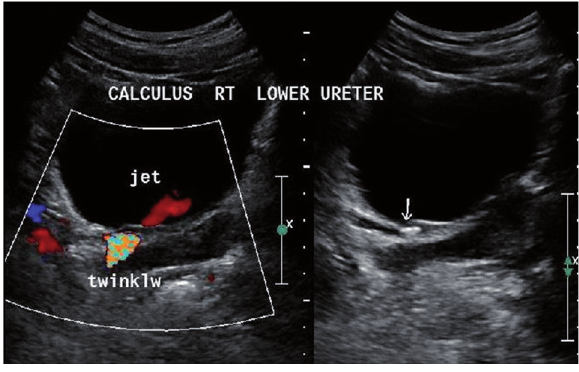
Figure 2 - Stone in the lower end of the ureter by gray scale ultrasound and the twinkling sign after the application of the color Doppler